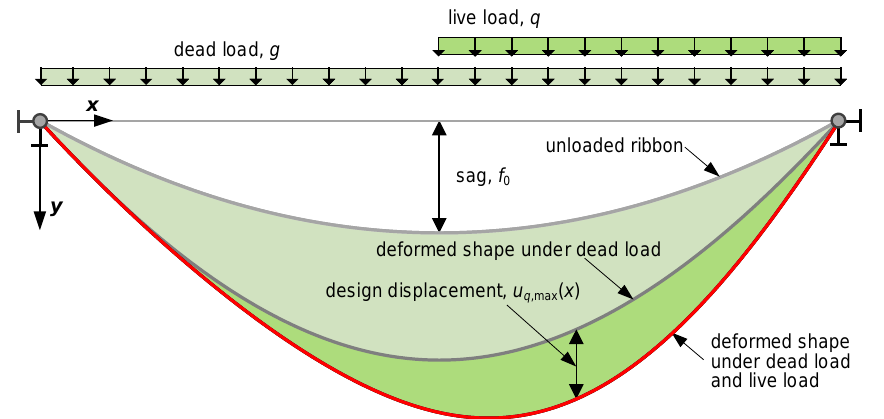
Figure 1. The design scheme of a stress-ribbon bridge.